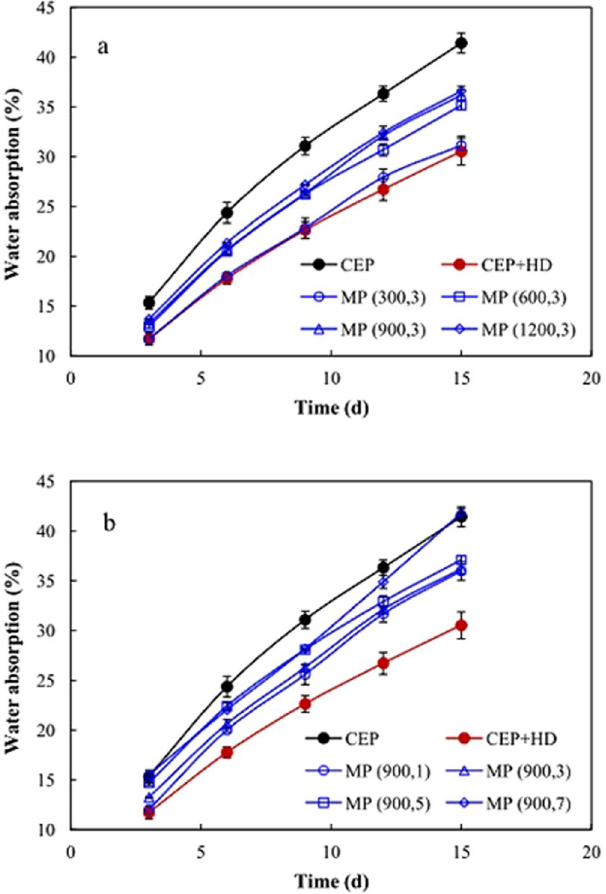
Figure 5. Water absorption of isolated films prepared via CEP, CEP + HD and MP under different homogenizer pressure ( a ) and pass number ( b ). CEP denotes conventional emulsion polymerization, CEP + HD represents the emulsion containing HD synthesized by CEP, MP (m, n) signifies miniemulsion polymerization through homogenizer pressures of m, and pass number of